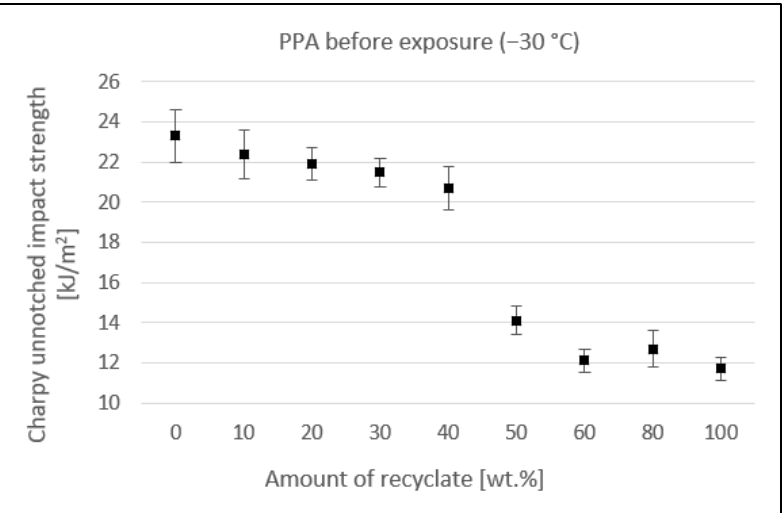
Figure 8. Dependence of the unnotched impact strength of PPA on the amount of recycled material before the samples were exposed to elevated temperature ( − 30 °C).